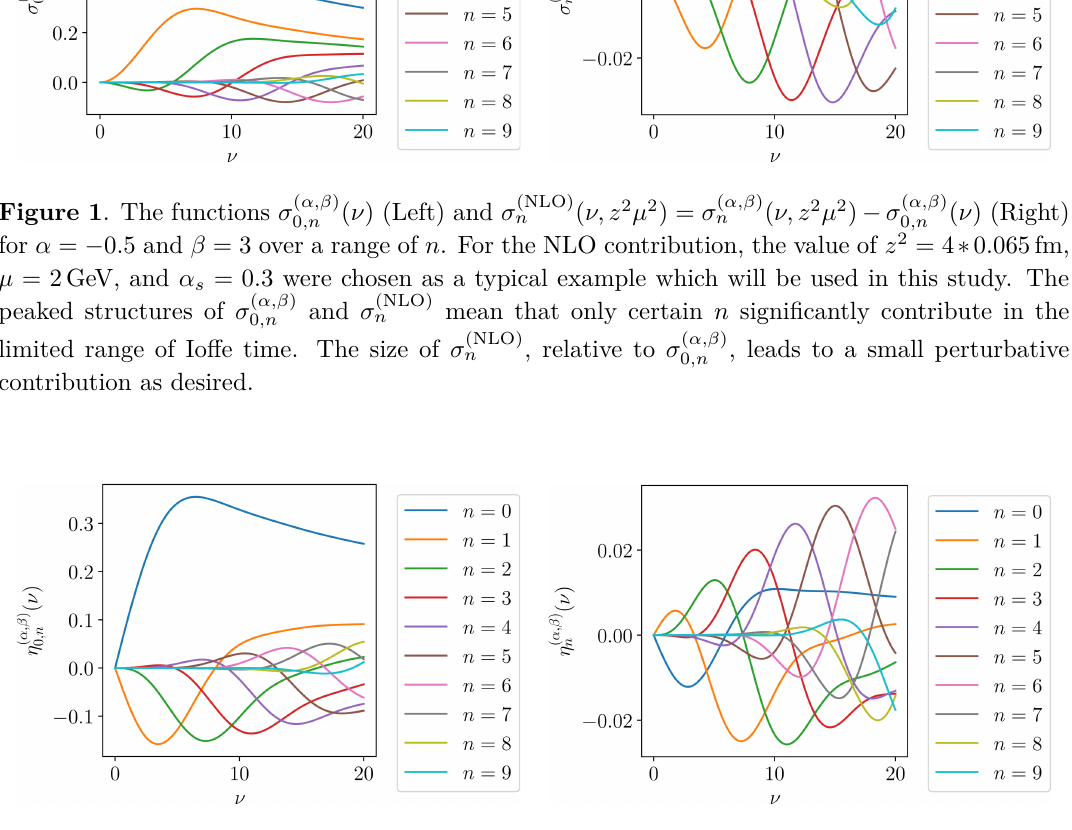
Figure 2 . The functions η ( α,β ) ( ν ) (Left) and η (NLO) n ( ν, z 2 µ 2 ) = η ( α,β ) n ( ν, z 2 µ 2 ) − η ( α,β ) ( ν ) (Right) 0 ,n 0 ,n for α = − 0 . 5 and β = 3 over a range of n . For the NLO contribution, the value of z 2 = 4 ∗ 0 . 065 fm, µ = 2 GeV, and α s = 0 . 3 were chosen as a typical example which will be used in this study. The peaked structures of η ( α,β ) and η (NLO) n mean that only certain n significantly contribute in the 0 ,n limited range of Ioffe time. The size of η (NLO) n , relative to η ( α,β ) , leads to a small perturbative 0 ,n contribution as